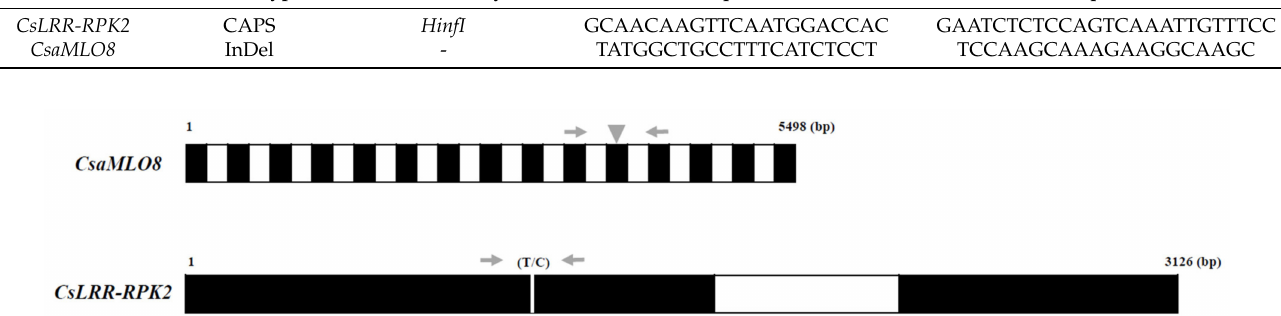
Figure 2. Schematic structure of two PM resistance alleles ( CsLRR-RPK2 and CsaMLO8 ). Exon–intron structures of CsaMLO8 and CsLRR-RPK2 genes are represented by black and white boxes, respectively. The gray arrows represent the forward and reverse primers of CsaMLO8 -InDel and CsLRR-RPK2 -CAPS markers, respectively. The gray triangle in the 11 leventh exon of CsaMLO8 represents the position of 1449 bp insertion. The white bar in the 1first exon of CsLRR-RPK2 represents the SNP (T/C). The digits, 1-5498 and 1-3126 represent the genomic DNA length of CsaMLO8 and CsLRR-RPK2 ,